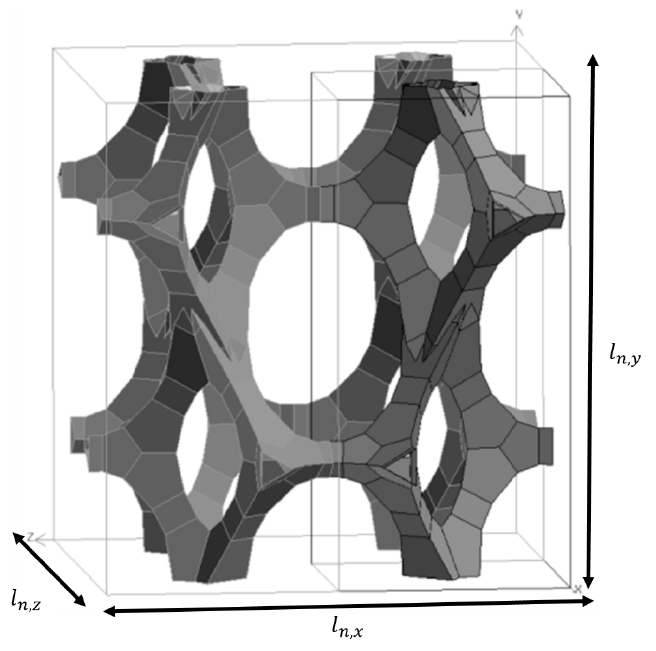
Figure 6. An illustration of a periodic unit cell from the model of De Jaeger et al. [56] (Foam 1